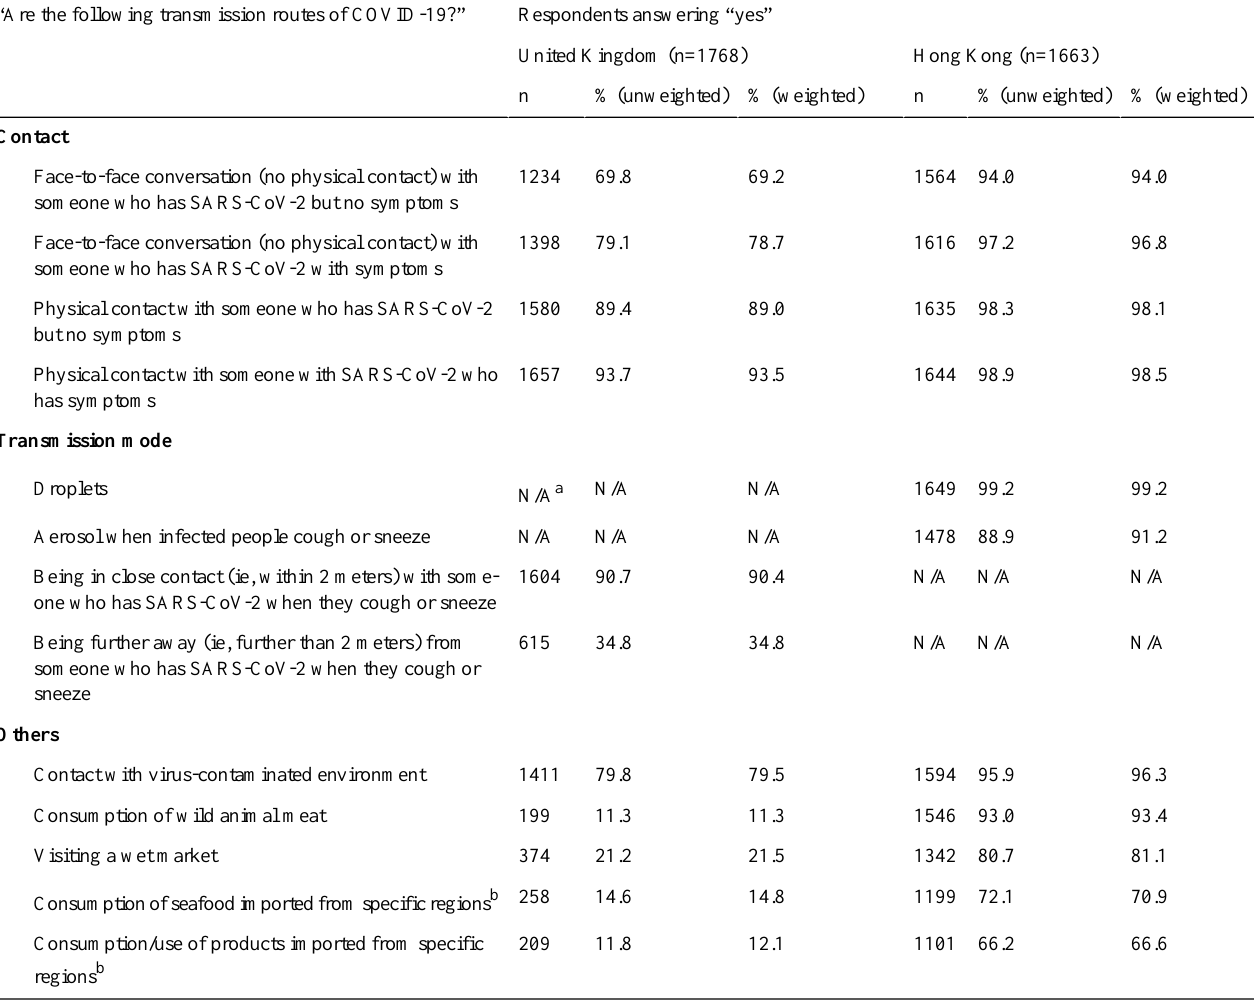
Table 2. Knowledge of COVID-19 transmission.